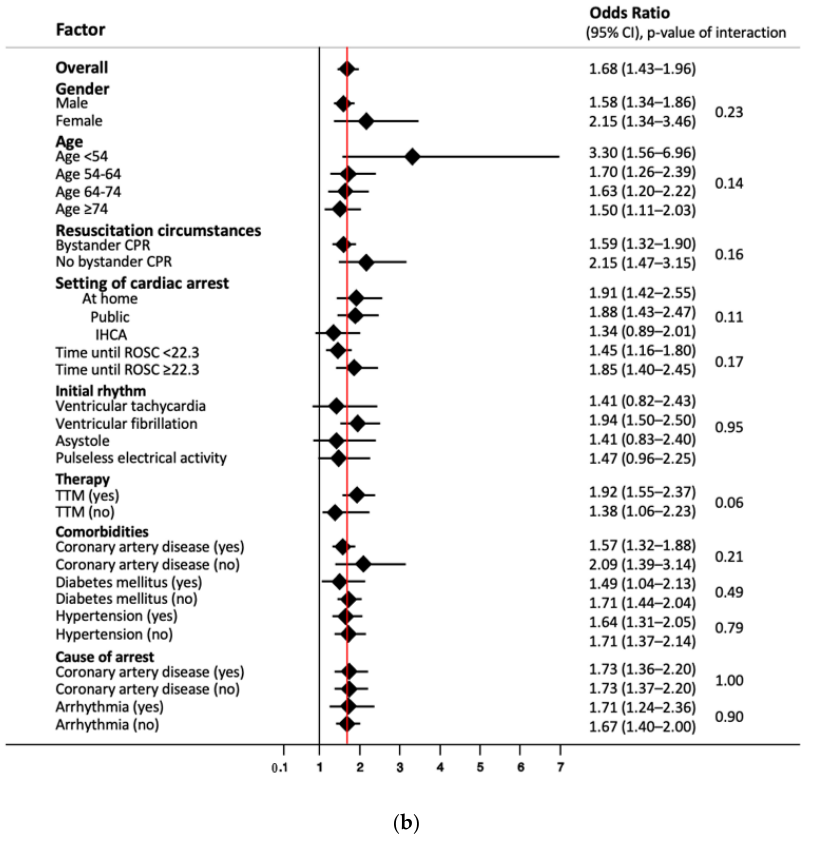
Figure 2. ( a ) Subgroup analysis of NSE levels on day three for endpoint overall long-term mortality. Data presented as hazard ratio (95% confidence interval); CPR, cardiopulmonary resuscitation; IHCA, in-hospital cardiac arrest; ROSC, return of spontaneous circulation; TTM, targeted temperature management. ( b ) Subgroup analysis of NSE levels on day three for endpoint neurological outcome after 2 years. Data presented as odds ratio (95% confidence interval); CPR, cardiopulmonary resuscitation; IHCA, in-hospital cardiac arrest; ROSC, return of spontaneous circulation; TTM, targeted temperature management.